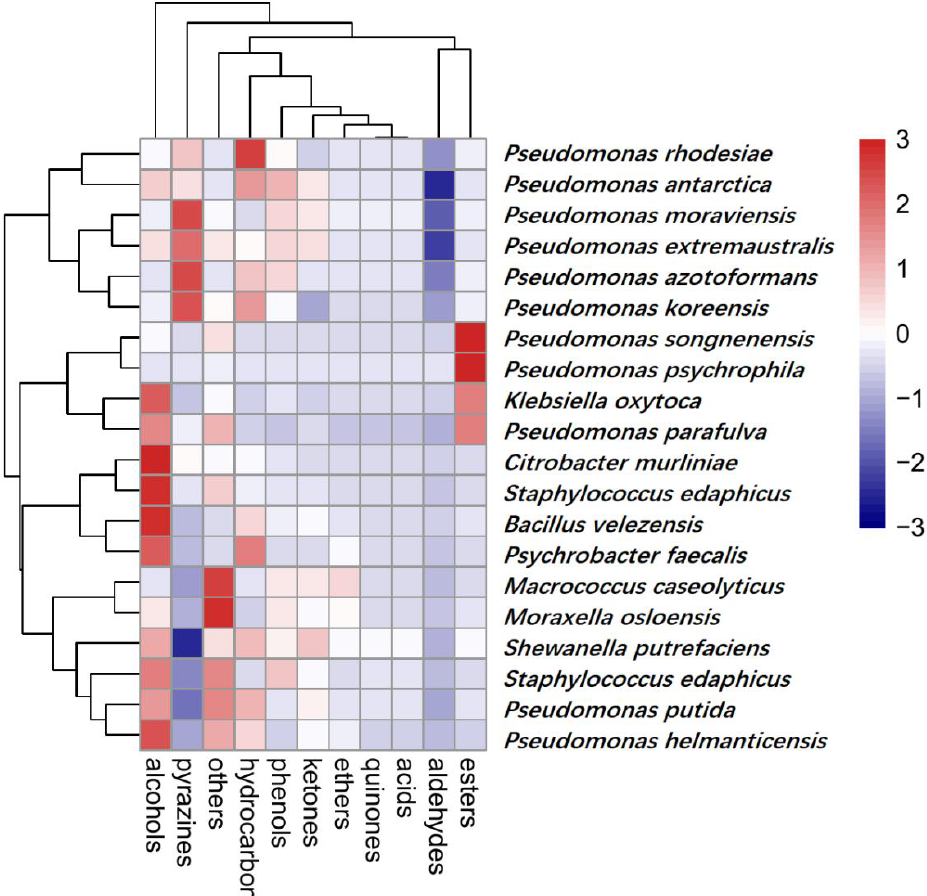
Figure 5. Heatmap showing the relative content of various aroma categories in isolates. Those with the highest abundant relationships are in red, while those with the lowest abundant relationships are in blue.